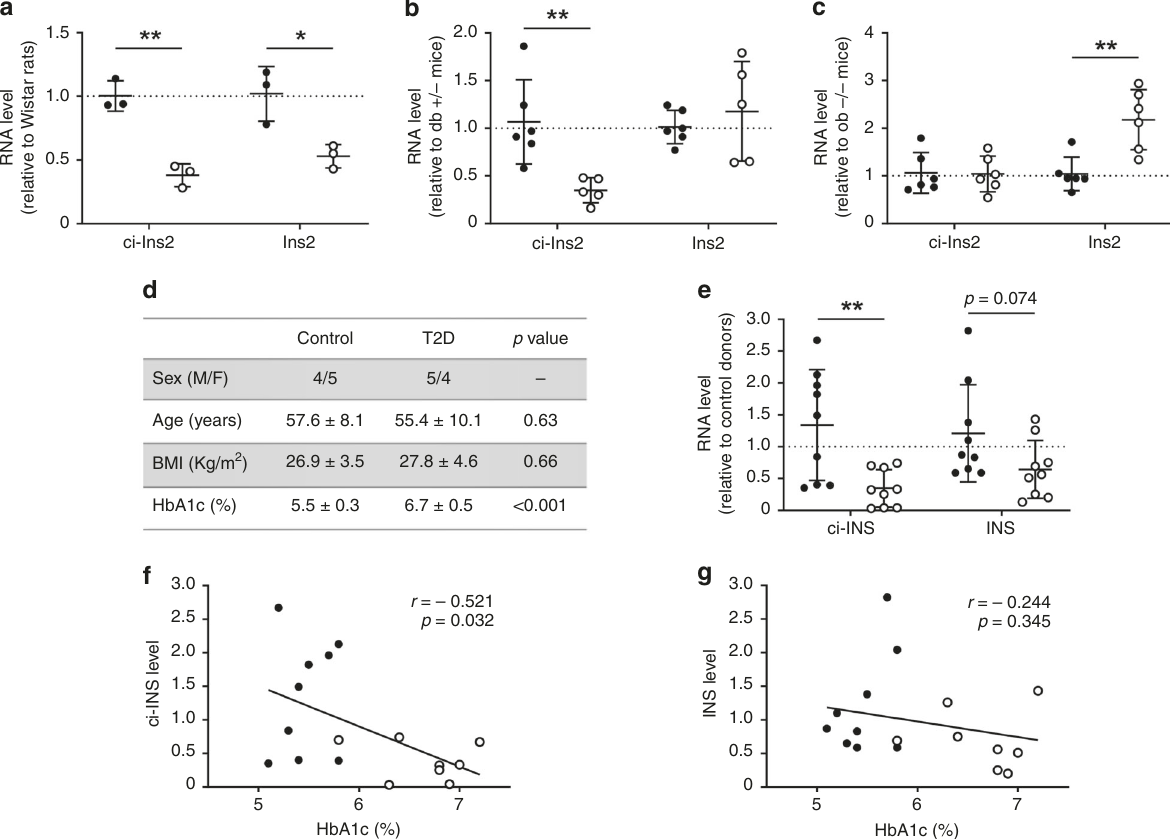
Fig. 9 ci-Ins2 and ci-INS levels are low in type 2 diabetes rodent models and human donors. a – c Islet ci-Ins2 and Ins2 normalized to Hprt1 , measured by qPCR, and expressed relative to control in ( a ) type 2 diabetes Goto-Kakizaki (clear circles) relative to Wistar (black circles) rats ( n = 3), b type 2 diabetes db + / + (clear circles) relative to db + / − (black circles) mice ( n = 5 ( db + / + ) and 6 (d b + / − ), and ( c ) ob + / + (clear circles) relative to ob − / − (black circles) mice ( n = 6). d Characteristics of human donors ( n = 8 (type 2 diabetes (T2D) HbA1c) and 9, Supplementary Table 10). e Islet ci-INS and INS normalized to HPRT1 and 18S, measured by qPCR, in type 2 diabetes (clear circles) relative to control (black circles) donors ( n = 9). a – e Data and mean are represented ± s.d. * p = 0.022 and ** p ≤ 0.01 by two-tailed unpaired t -test. f , g Correlation of ( f ) ci-INS and ( g ) INS relative islet RNA levels with HbA1c in control (black circles) and type 2 diabetes (clear circles) donors ( n = 8 (type 2 diabetes) and 9 (control)). p < 0.05 by two-tailed Pearson test was considered signi fi cant. Source data are provided as a Source Data fi